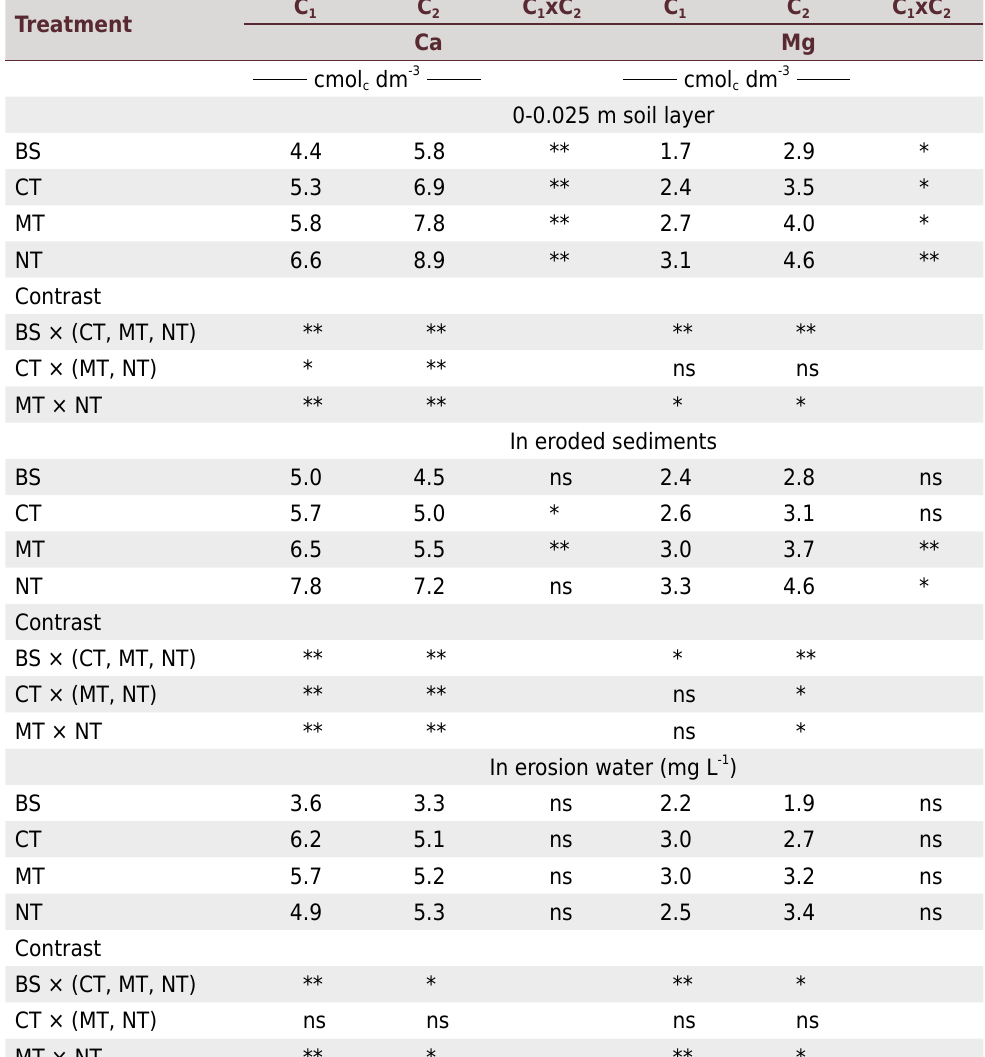
Table 2. Exchangeable calcium and magnesium contents in the 0-0.025 m layer of the soil, in the sediments and water from erosion under natural rainfall, in a Humic Cambisol, under different systems of land use and soil management (average of 15 years)